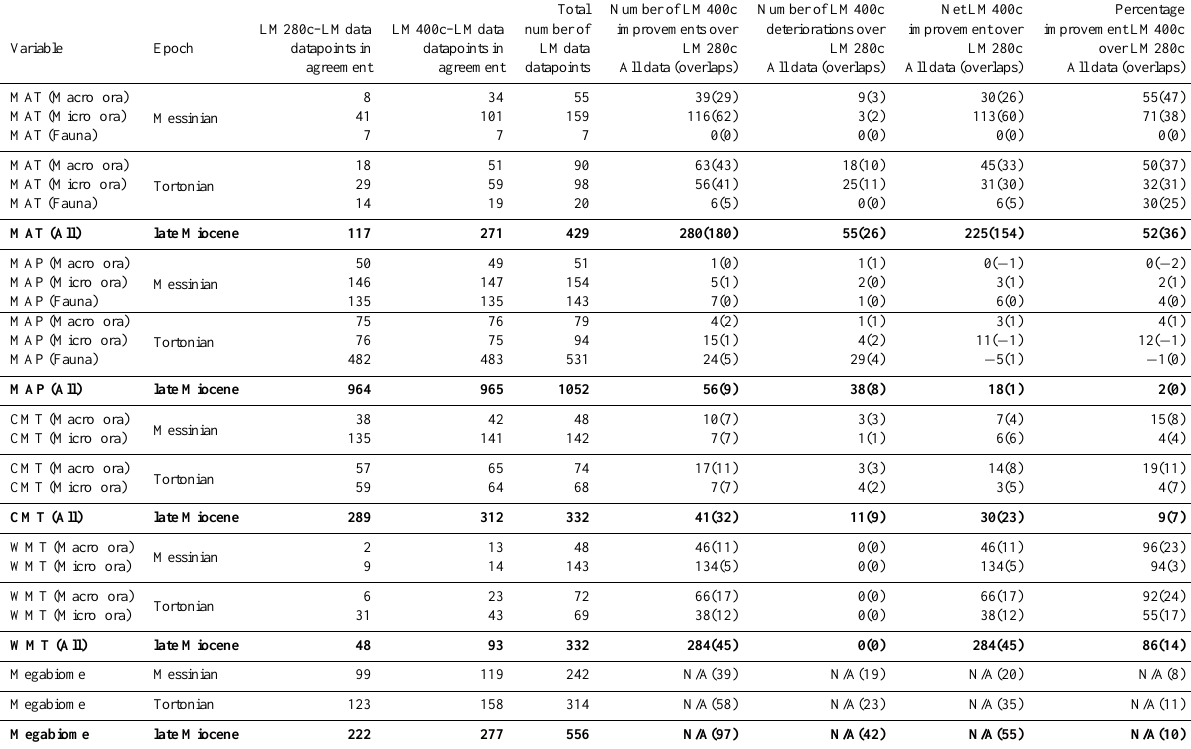
Table 3. Results from the model–data comparison for high and low CO 2 concentration assumptions. Totals are expressed in